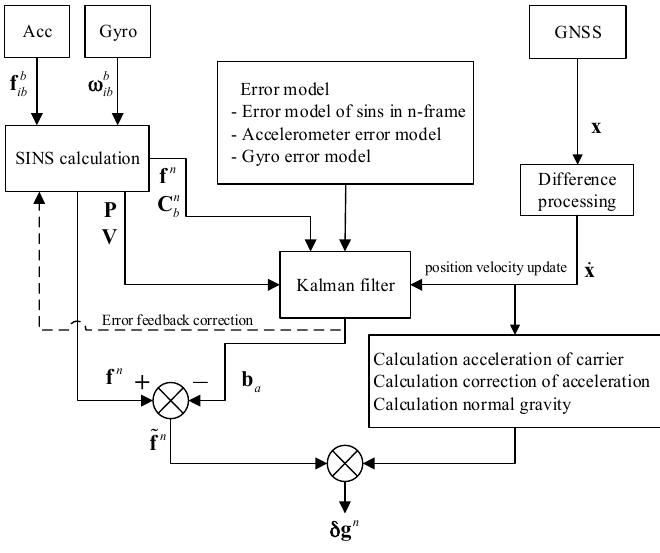
Figure 1. Data process flow chart of strapdown airborne gravimeter.